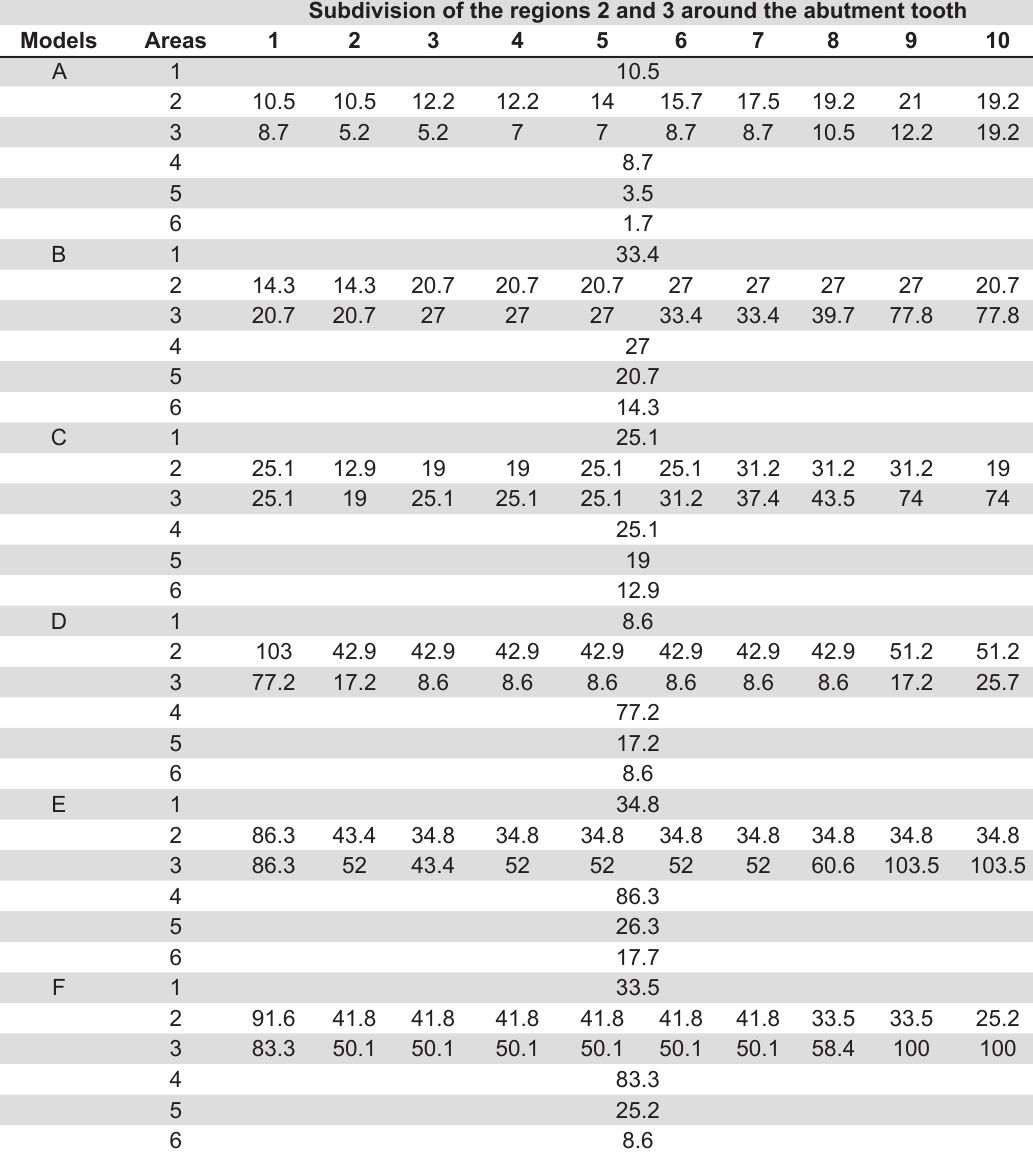
), in MPa, for the cortical bone according to specific areas in models A to F. Note the Table 2- von Mises stress ( s vM subdivision of regions 2 and 3 into 10 segments (1 to 10) around the abutment